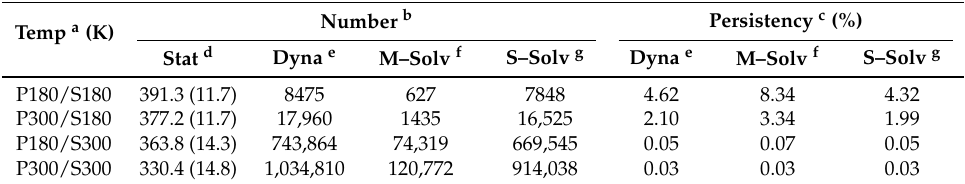
Table 3. Properties of HBs formed between proteinase K and the solvent calculated from the joined MD trajectories at the four combined